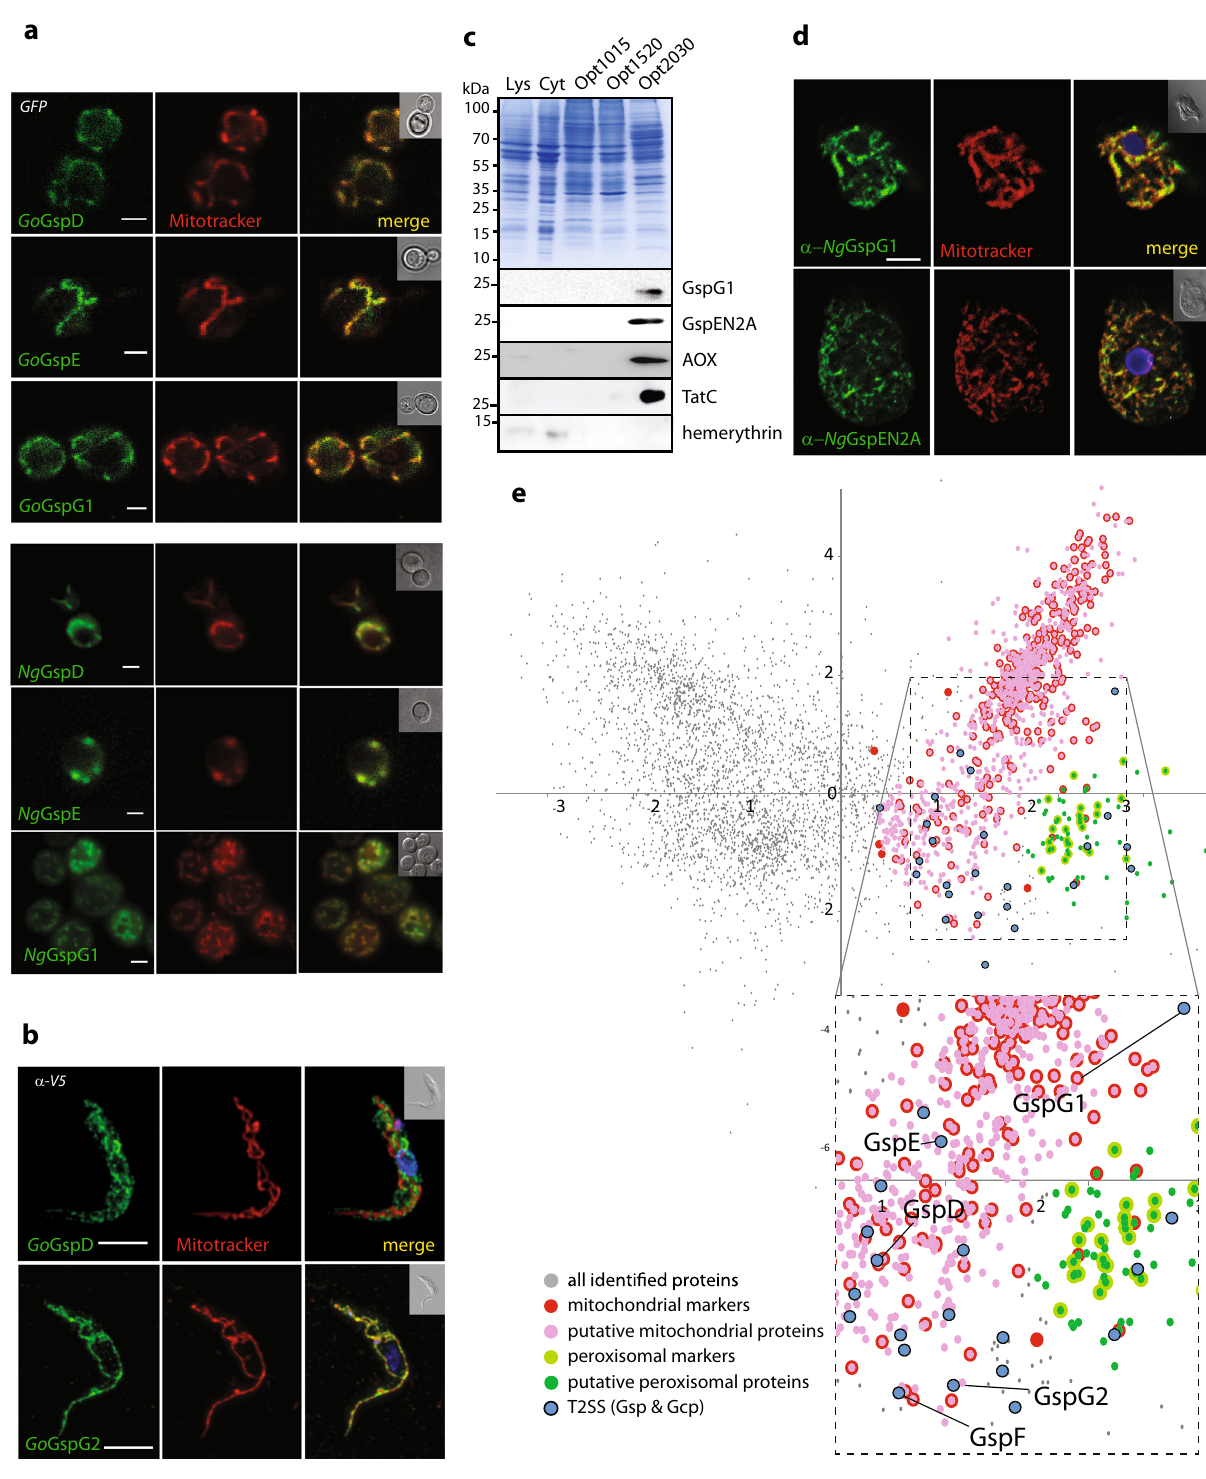
Fig. 3 Eukaryotic T2SS components are localised in mitochondria. a S. cerevisiae expressing G. okellyi and N. gruberi Gsp proteins as C-terminal GFP fusions stained with MitoTracker red CMX ROS to visualise mitochondria. b Expression of G. okellyi GspD and GspG2 with the C-terminal V5 Tag in T. brucei visualised by immuno fl uorescence; the cells are co-stained with MitoTracker red. c Cellular fractions of N. gruberi labelled by speci fi c polyclonal antibodies raised against GspG1, GspEN2A and mitochondrial (alternative oxidase – AOX, TatC,) cytosolic (hemerythrin) marker proteins. d Immuno fl uorescence microscopy of N. gruberi labelled with speci fi c polyclonal antibodies raised against GspG1 and GspEN2A, and co-stained with MitoTracker red. Scale bar (parts a – d ), 10 µ m. (for a – d , representative images of multiple, at least three, experiments are shown), e PCA analysis of 4198 proteins identi fi ed in the proteomic analysis of N. gruberi subcellular fractions differentially enriched in mitochondria. The cluster of mitochondrial proteins was de fi ned on the basis of 376 mitochondrial markers. The boundaries of the cluster of co-puri fi ed peroxisomal proteins were de fi ned by 26 peroxisomal